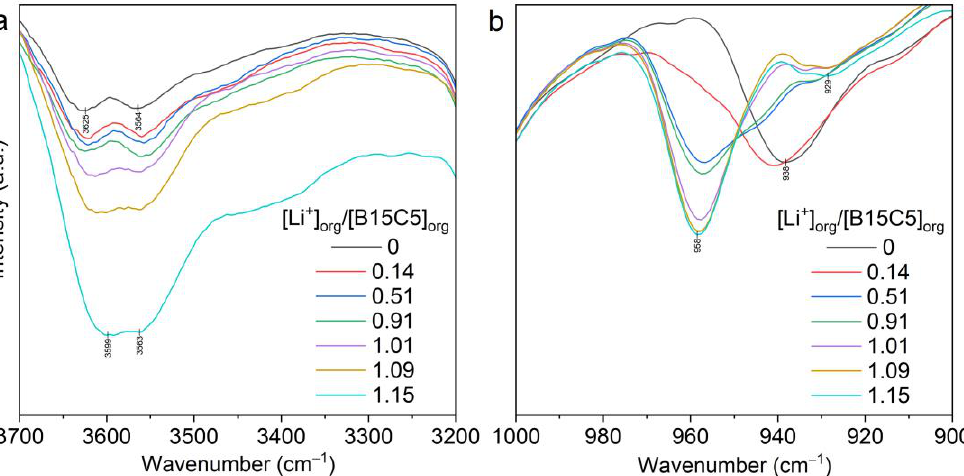
Figure 14. FTIR spectra of LiNTf 2 -B15C5 (0.5 mol/L)-[C8mim][NTf 2 ] extract at the different [Li + ]/[B15C5] ratios in the ranges of 3700 – 3200 cm −1 ( a ) and 1000 – 900 cm −1 ( b ).